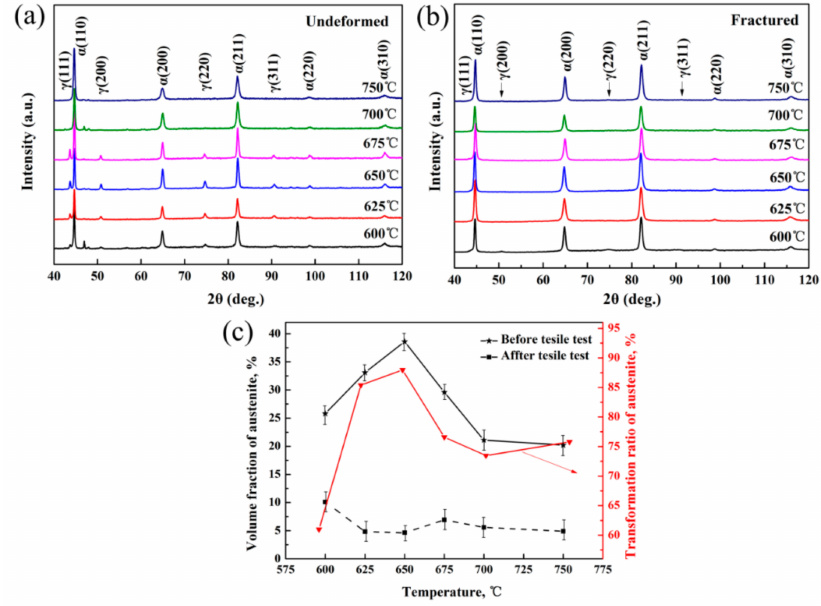
Figure 6. XRD pattern and measured austenite fraction of experimental steels at different annealing temperatures: ( a ) undeformed, ( b ) fractured, ( c ) austenite fraction calculated using Equation (1) and transformation ratio of